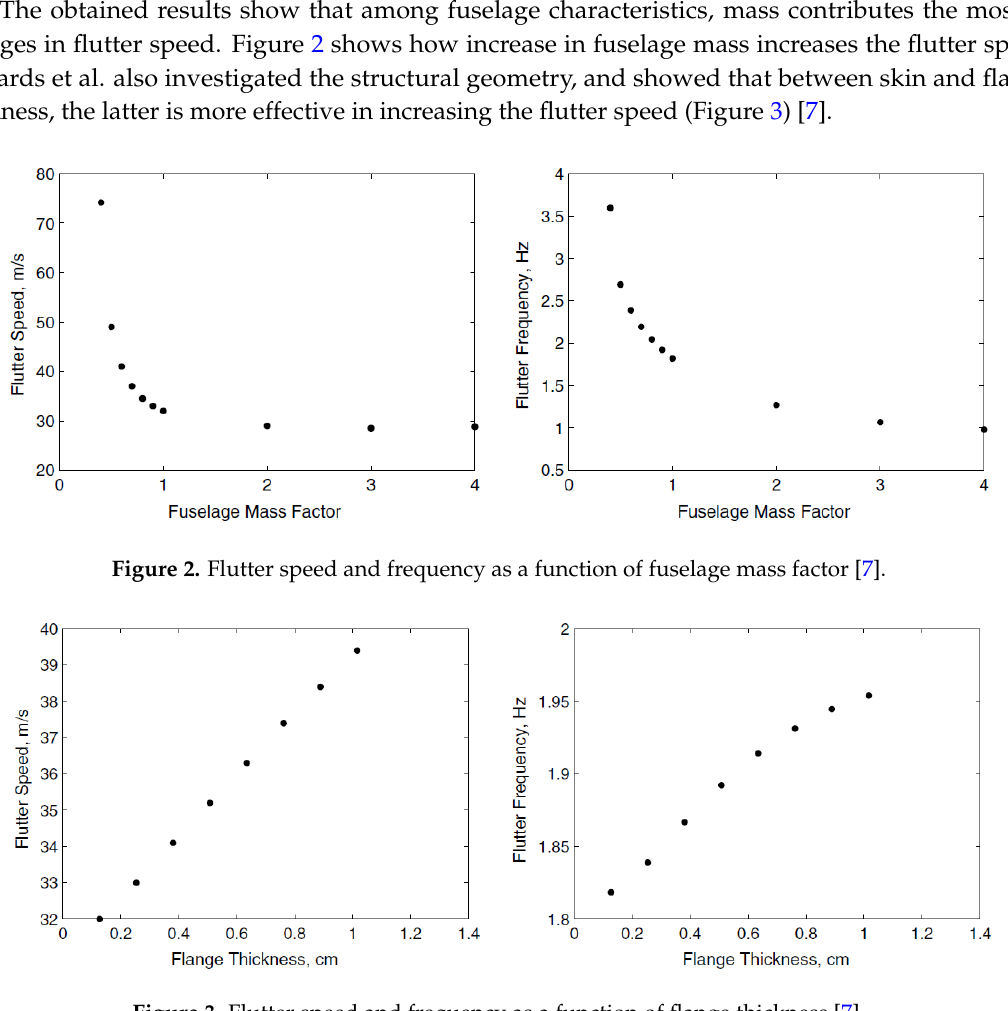
Figure 3. Flutter speed and frequency as a function of flange thickness